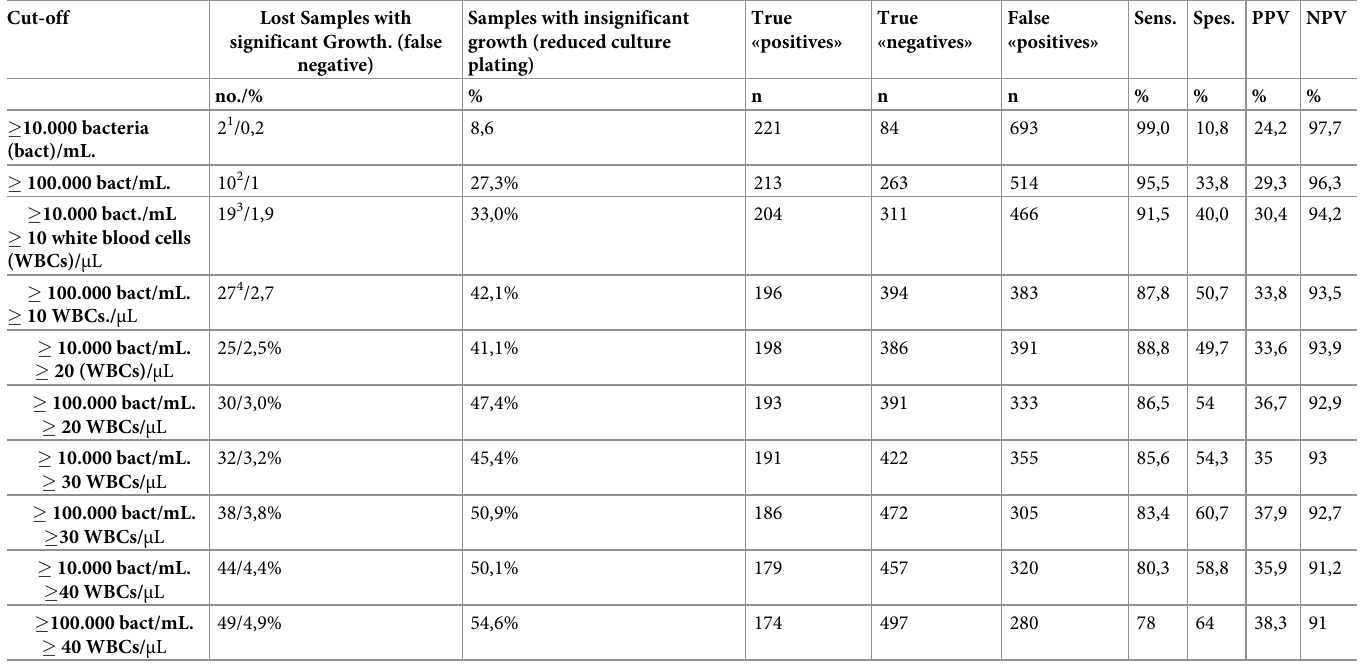
Table 3. Evaluation of different cut-off values for WBCs and bacteria on flowcytometry. Cut-off